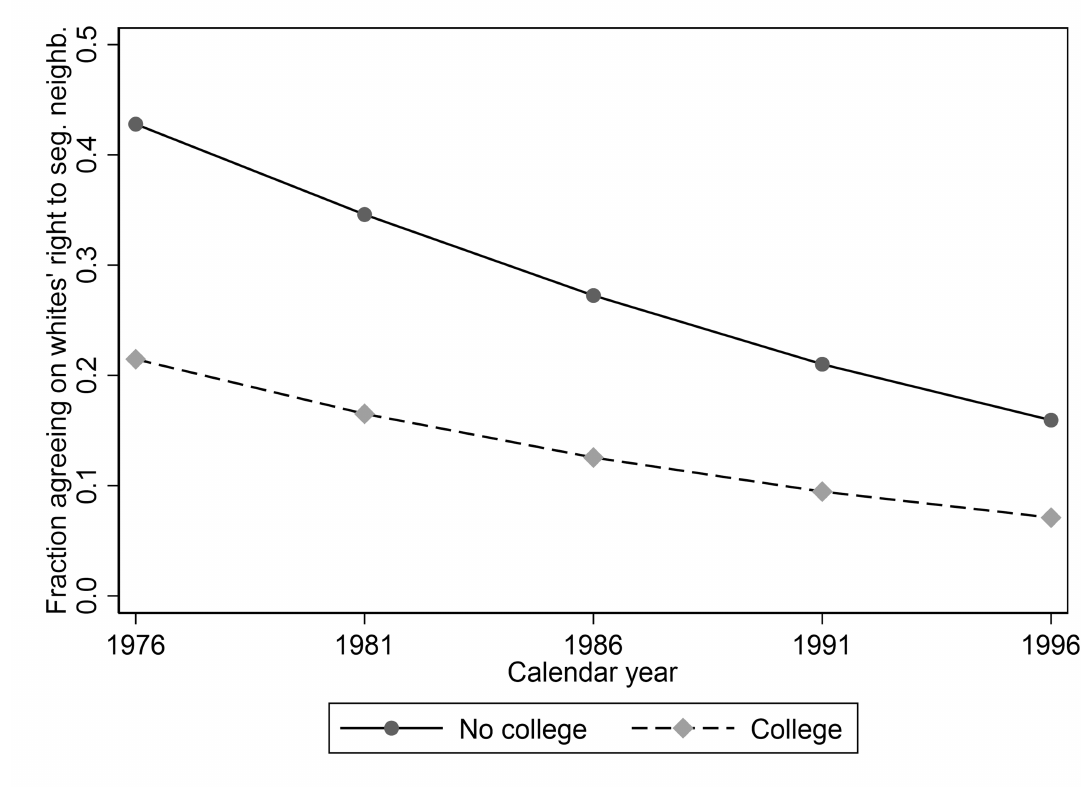
Figure 1: Trends among college-educated and non–college-educated individuals in the attitude toward whites’ right to live segregated from blacks, 1976 to 1996: average marginal predictions. Notes : Estimates are adjusted for gender, race, age, marital status, and overall political view. Data are from the General Social Survey cumulative file, N = 12,